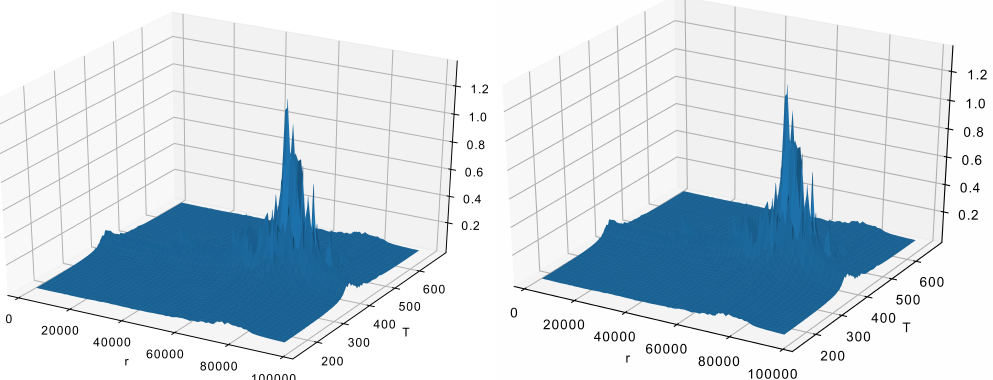
Figure 6. Use of too much Fourier-transformed data (64 × 64 in the left ) and full reconstruction ( right ).